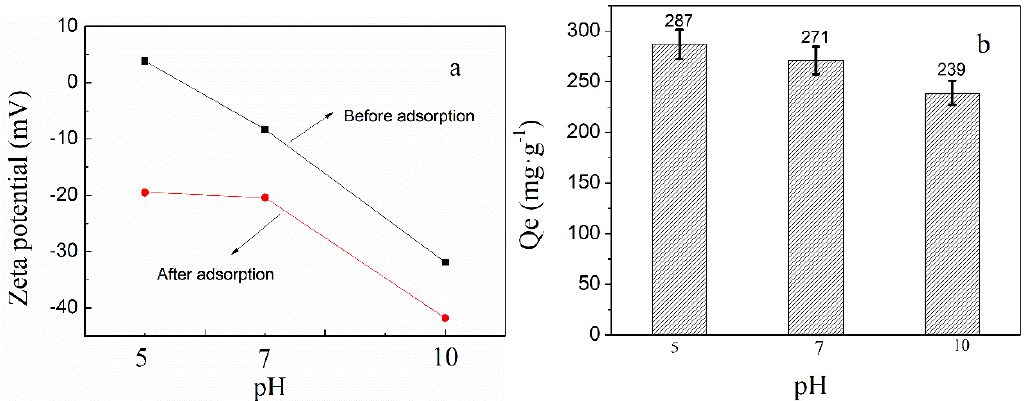
Figure 9. Zeta potential of PNIPAM/SiO 2 particles before and after adsorption of phosphate anions at different pH ( a ) and phosphate adsorption capacity of PNIPAM/SiO 2 particles after adsorption at different pH ( b ).